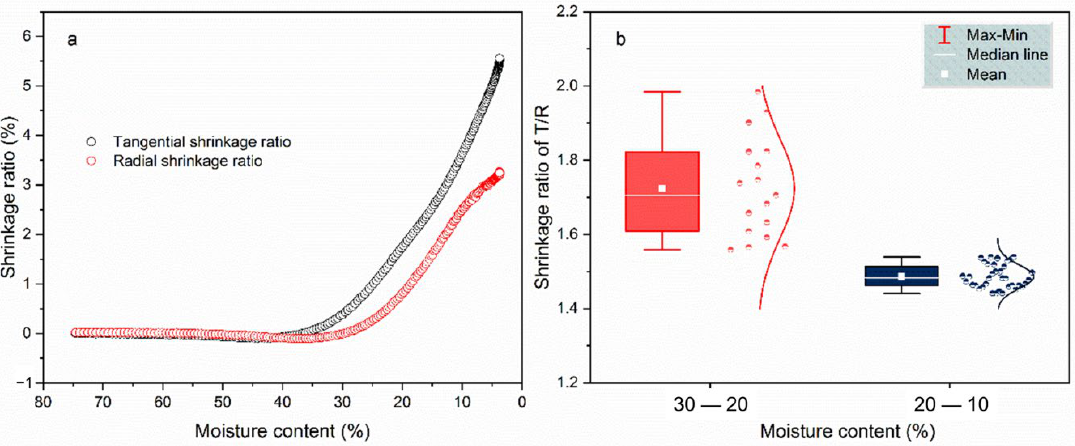
Figure 5. The shrinkage ratio ( a ) in T and R directions and T/R ratio ( b ) at different MC regions.